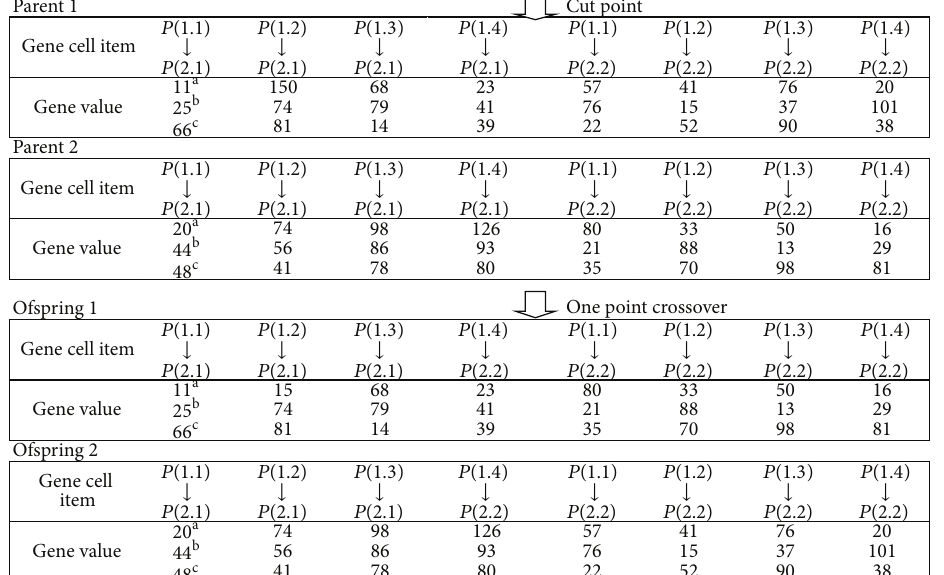
Figure 3: Single-point